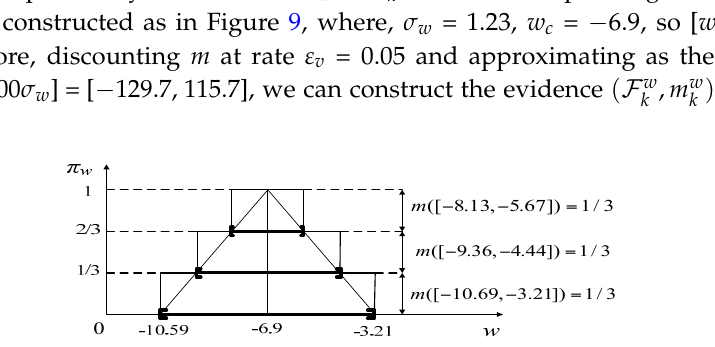
Figure 9. Probability distribution π w of observation noise w .